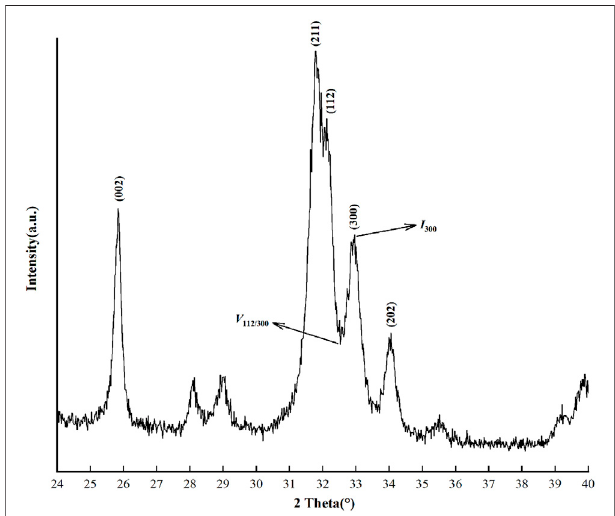
FIGURE 3 | Diffraction pattern of powder hydroxyapatite with 99% purity.